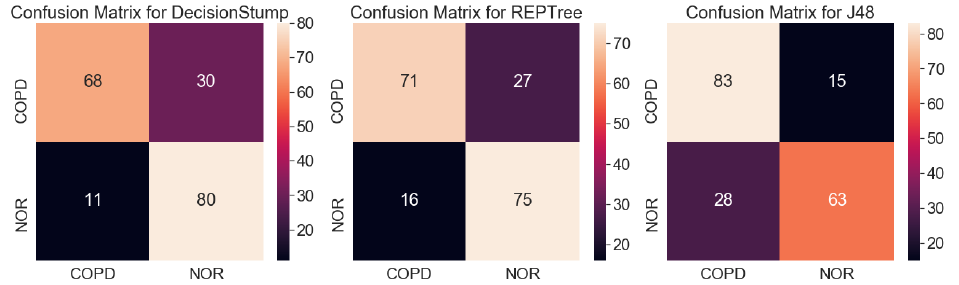
Figure 7. Confusion matrices for results showed in Figure 6.